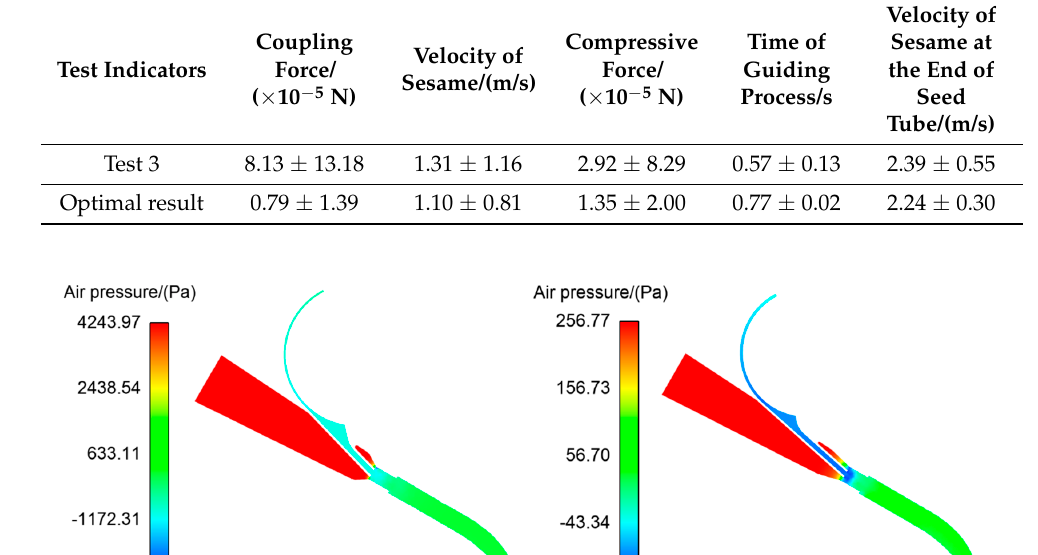
Table 4. Statistical force and velocity of seeds in guiding process.